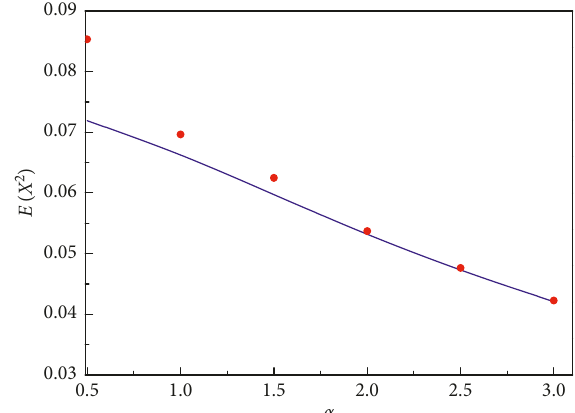
Figure 4: The mean square displacement E [ X 2 ] vs. excitation parameter D (solid line: the analytical results; discrete symbols: Monte Carlo simulation results).